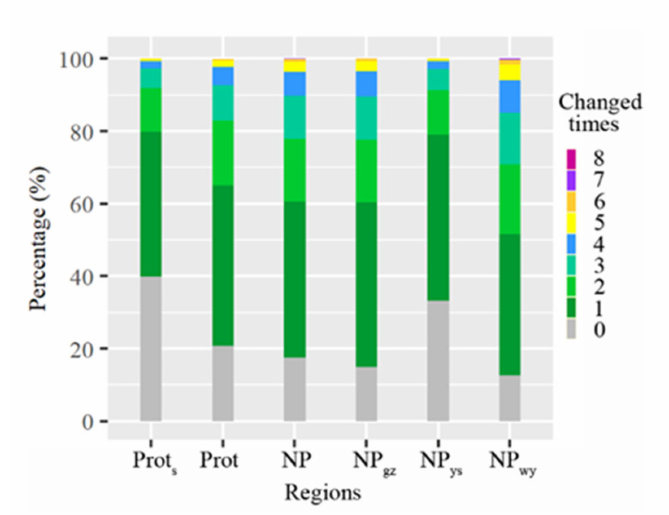
Figure 3. Percentage of the changed times in different regions from 1986 to 2020. Prot s : Wuyishan Nature Reserve; Prot: non-nature reserve within Wuyishan National Park; NP: non-protected area; NP gz : non-protected area in Guangze County; NP ys : non-protected area in Yanshan County; NP wy : non-protected area in Wuyishan City.